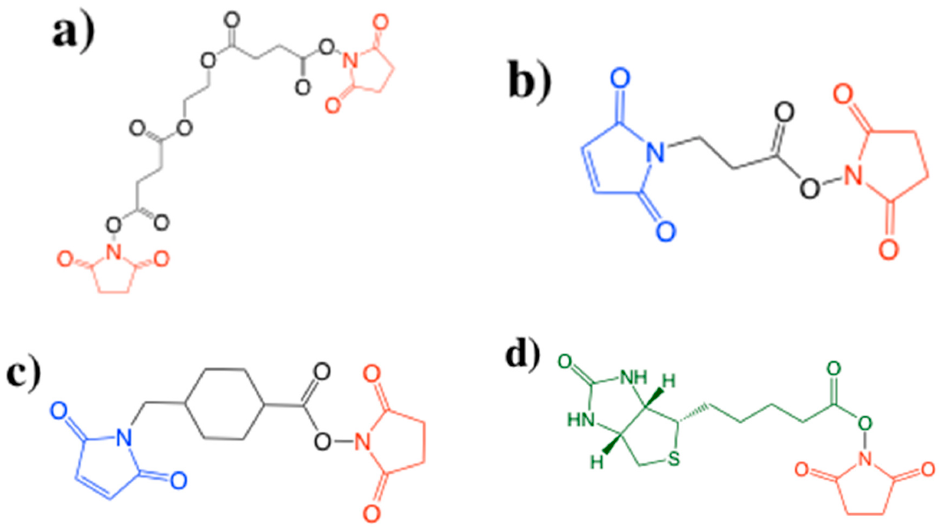
Figure 9. Chemical structures of NHS derivative crosslinkers ( a ) EGS; ( b ) NHS-Mal; ( c ) SMCC; ( d ) NHS-Biotin.